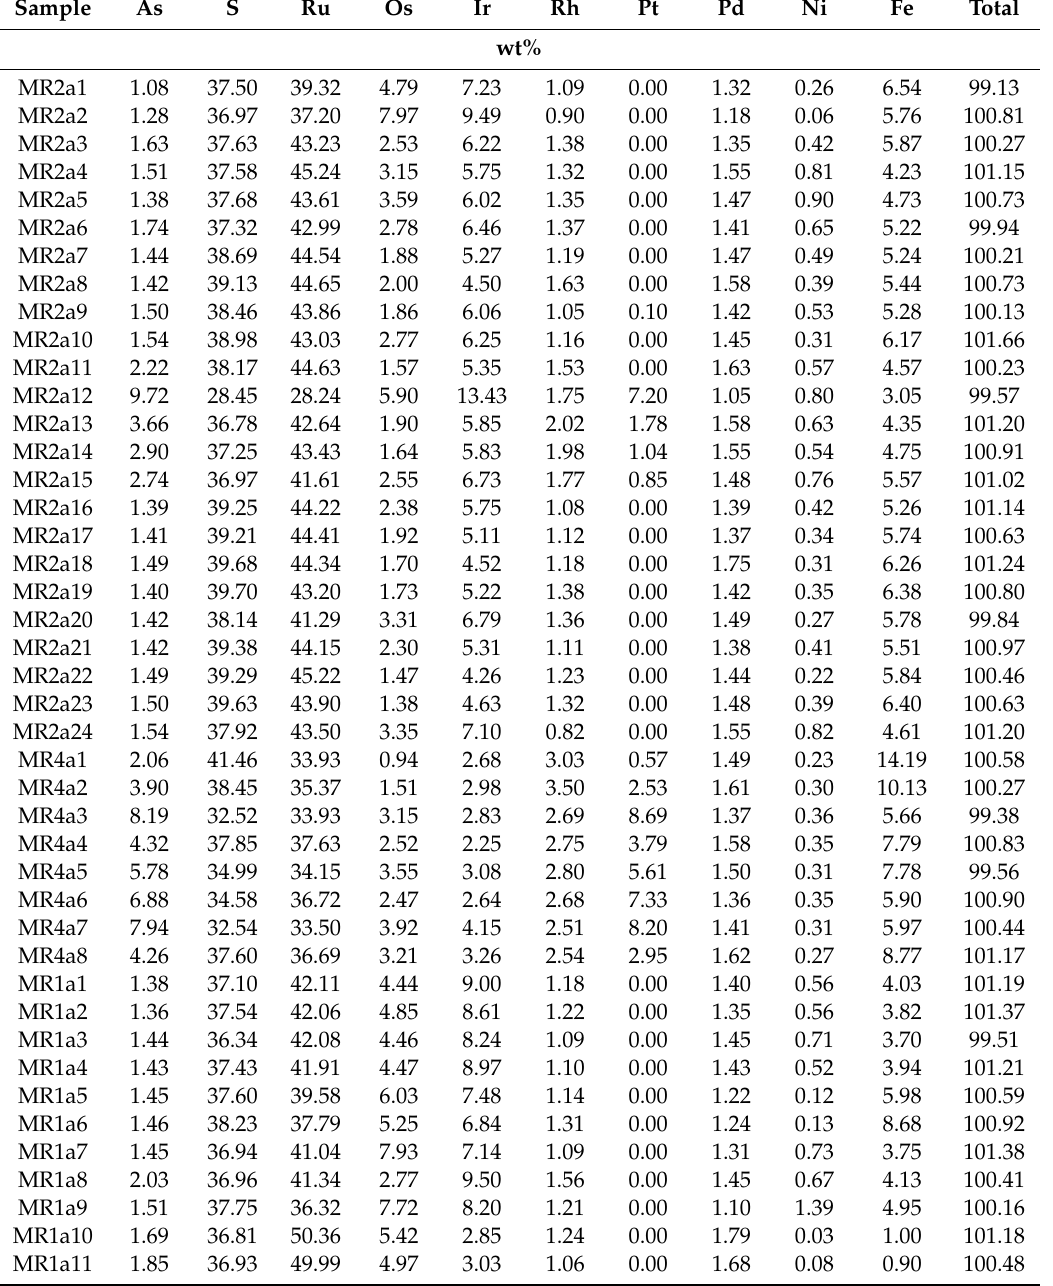
Table 2. WDS electron microprobe analyses of Merensky Reef zoned laurite.